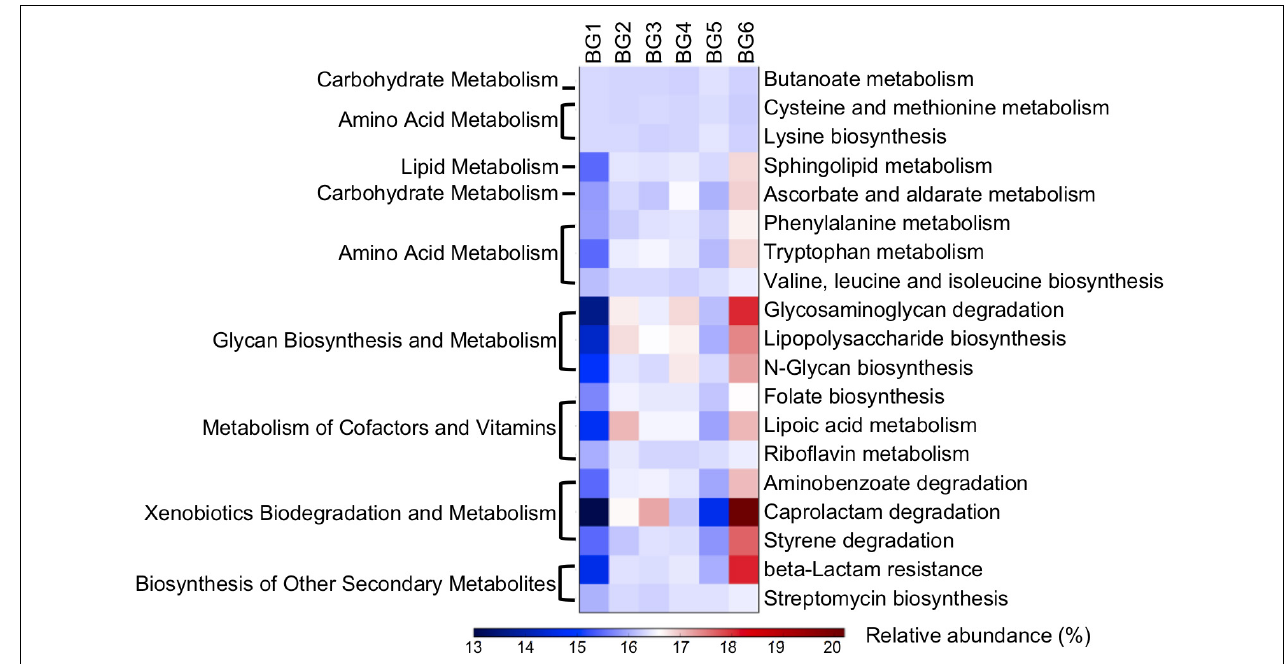
FIGURE 6 | A heatmap showing the difference in relative abundances of the microbial functional genes involved in KEGG pathways among six BGs. Only KEGG pathways with their relative abundance significantly correlated with breed composition ( P < 0.05) predicted by PICRUSt and consistent with shotgun metagenomics data were involved in the